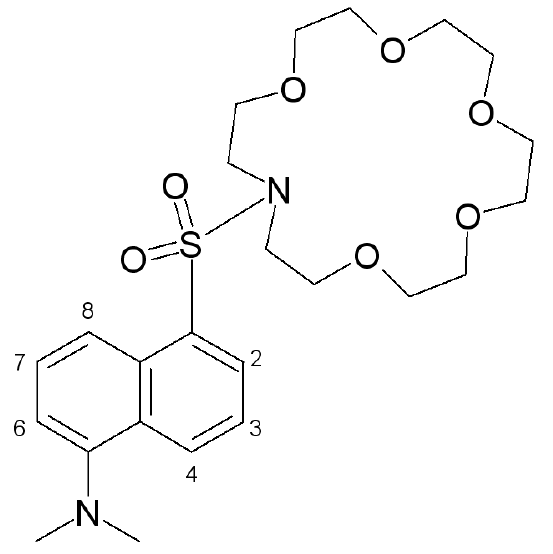
Fig. 1 Structure of the A18C6-Dns